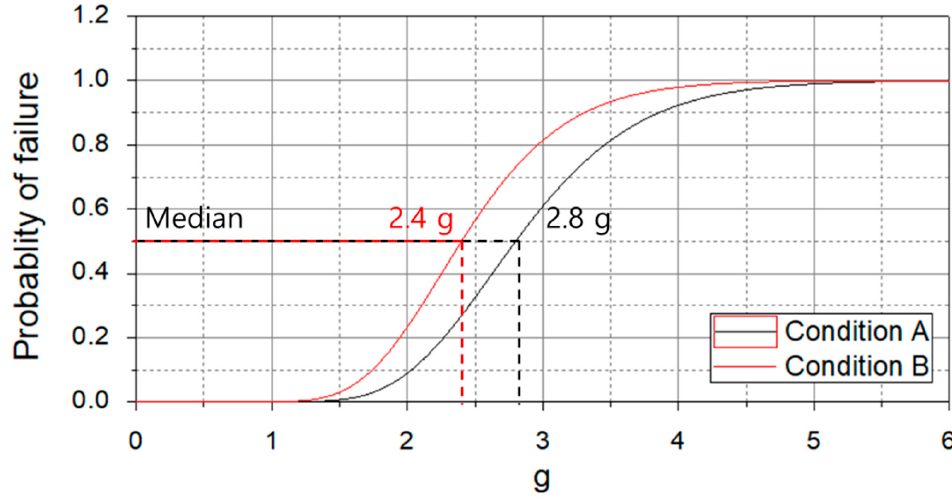
Figure 15. S eismic fragility curve of the piping system due to the convergence condition. Figure 15. Seismic fragility curve of the piping system due to the convergence